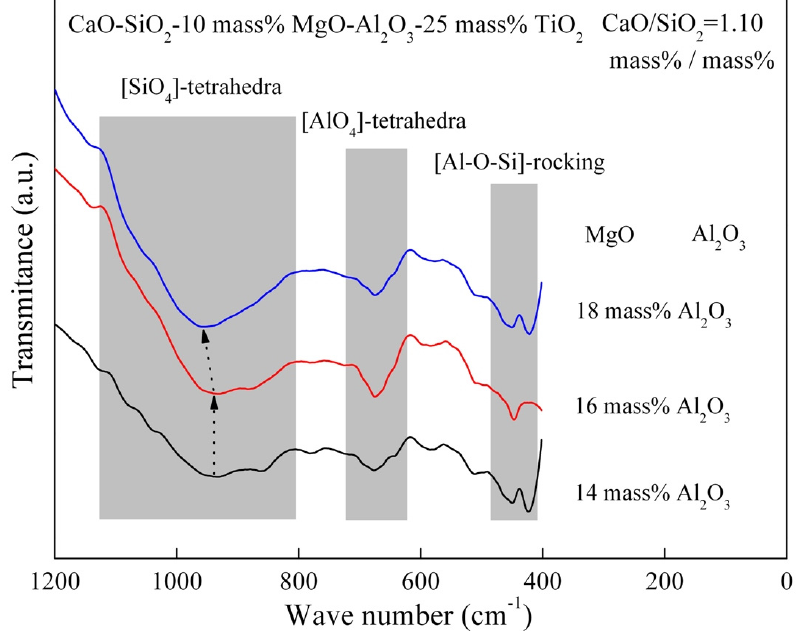
Figure 12. FT–IR transmittance spectra of the slag containing different Al 2 O 3 content at 1773 K.